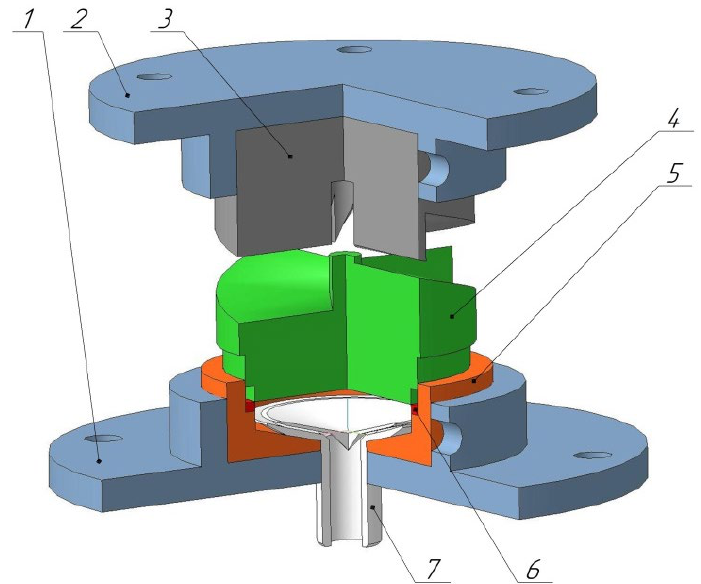
Figure 1. General view of the complete construction: 1—bottom carrier, 2—top carrier, 3—upper striker, 4—lower striker, 5—matrix, 6—piston ring, 7—nozzle. striker, 4—lower striker, 5—matrix, 6—piston ring,